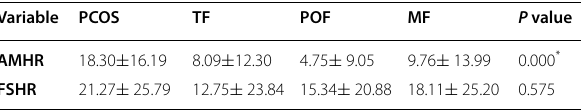
Table 2 Primer sequences for understudied genes Gene Primer sequence Length Product size Tm